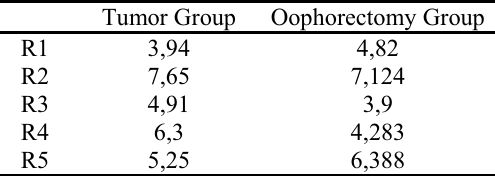
TABLE 1 - Weight of extracted tumor mass